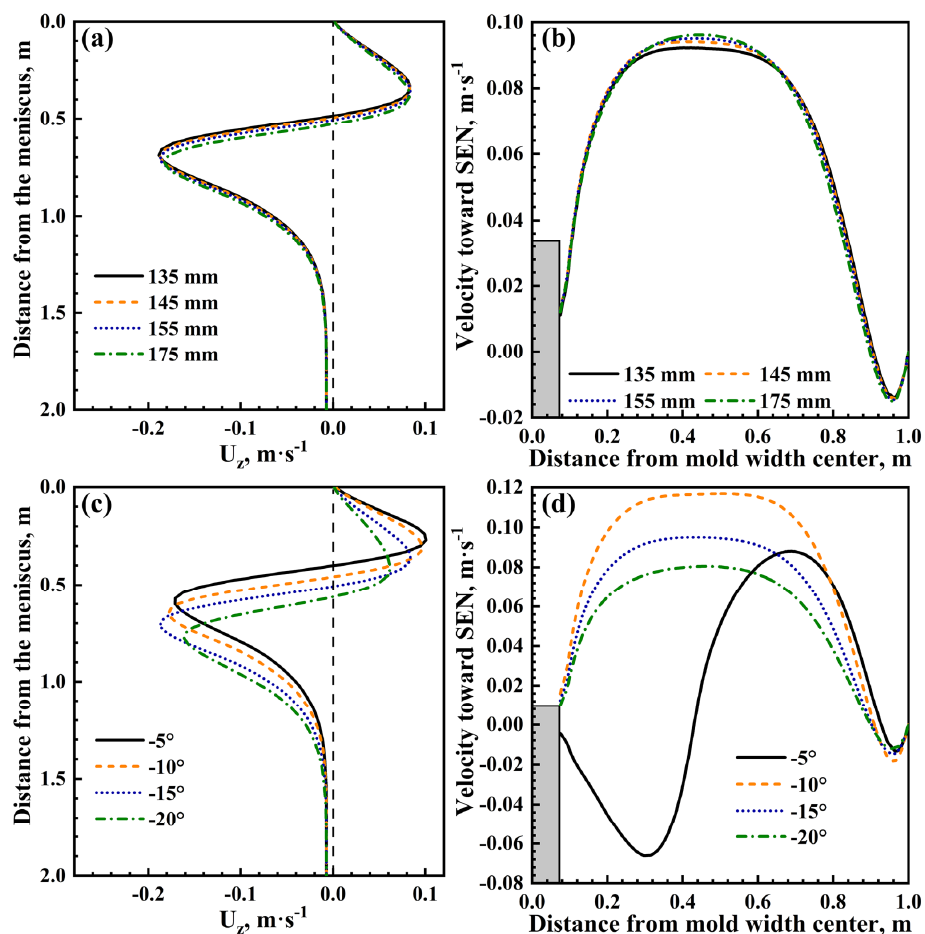
Figure 8. Longitudinal velocity profiles near NF solidification front along the casting direction ( a , c ) and horizontal velocity variations on the meniscus ( b , d ) with different SEN submerged depths and port angles. and port